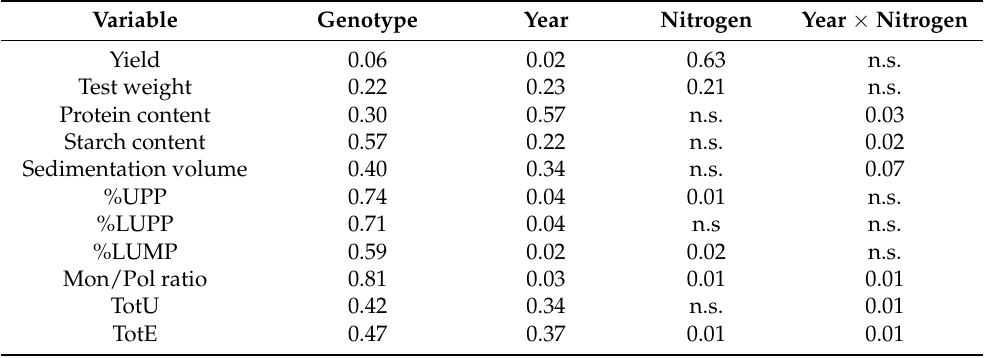
Table 2. ANOVA effect size ( ω 2 ) of genotype, year and nitrogen fertilizations on the winter wheat yield and quality traits. n.s.—not significant. Variable Genotype Year